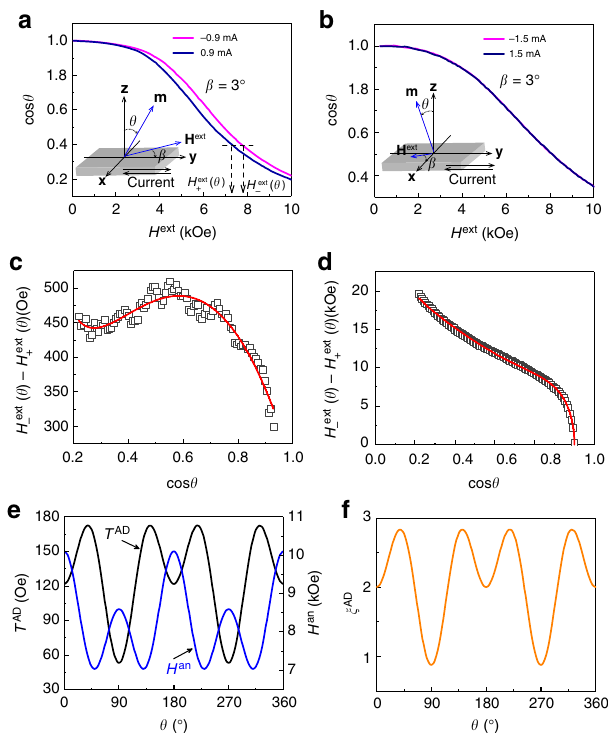
Fig. 3 Quanti fi cation of current-induced torque and magnetic anisotropy. Normalized R AHE (i.e., cos θ ) as a function of H ext for positive (along y ) and negative (along − y ) currents, when H ext is ( a ) in the yz -plane and b in the xz -plane. Insets of ( a ) and b show the measurement scheme. The curves were obtained at 300 K and β = 3°. c Values of H + ext ( θ ) − H − ext ( θ ) determined from the data in ( a ) (squares) and best- fi t curve obtained using Eq. 2 (solid line). d Values of H + ext ( θ ) + H − ext ( θ ) determined from the data in a (squares) and best- fi t curve obtained using Eq. 3 (solid line). e Dependences of T AD (black line) and H an (blue line) on θ . f ξ AD as a function of